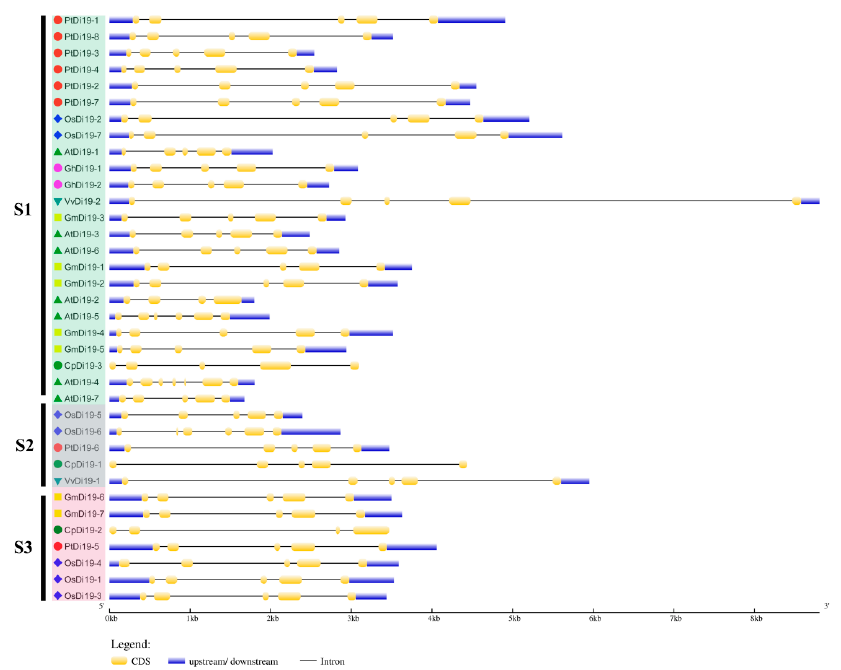
Figure 2. Gene structure of Di19s in seven species. Use GSDS online tool for gene structure analysis. Yellow boxes and black lines represent exons and introns, respectively. Blue box indicates the 5 ′ and 3 ′ non-coding regions. The length represents the size of exon and intron.